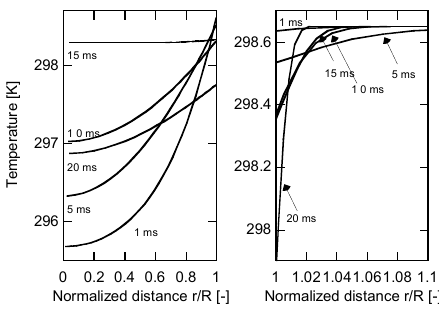
Fig. 7 Instantaneous spatial distributions of temperature in the bubble (left) and in the liquid (right) for the radial motion in Fig. 5.